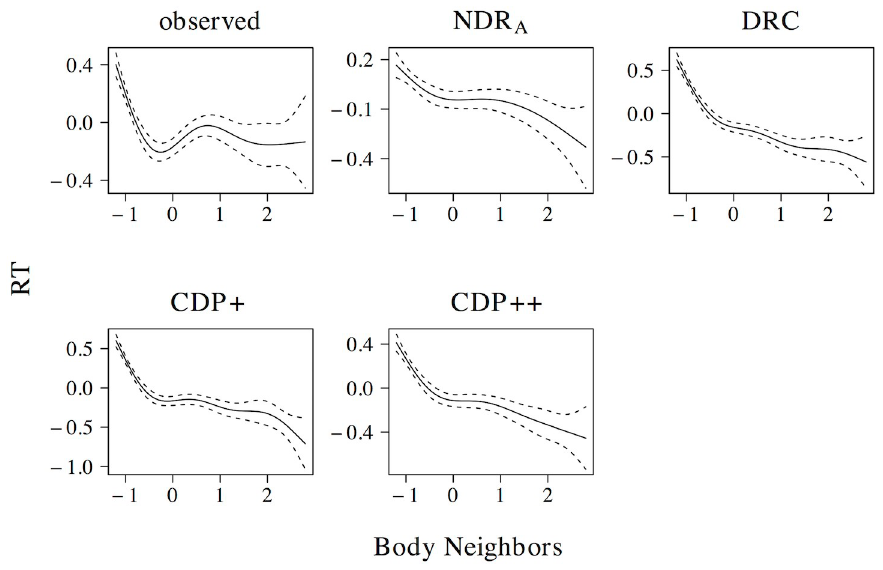
Fig 8. Body neighborhood density. The effect of body neighborhood density in word naming.